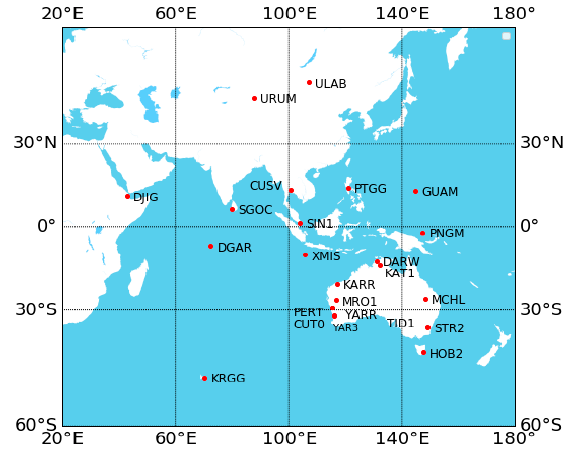
Figure 1. Distribution of the 24 stations that were used for the precise point positioning (PPP) processing and the inter-system bias (ISB) analysis.